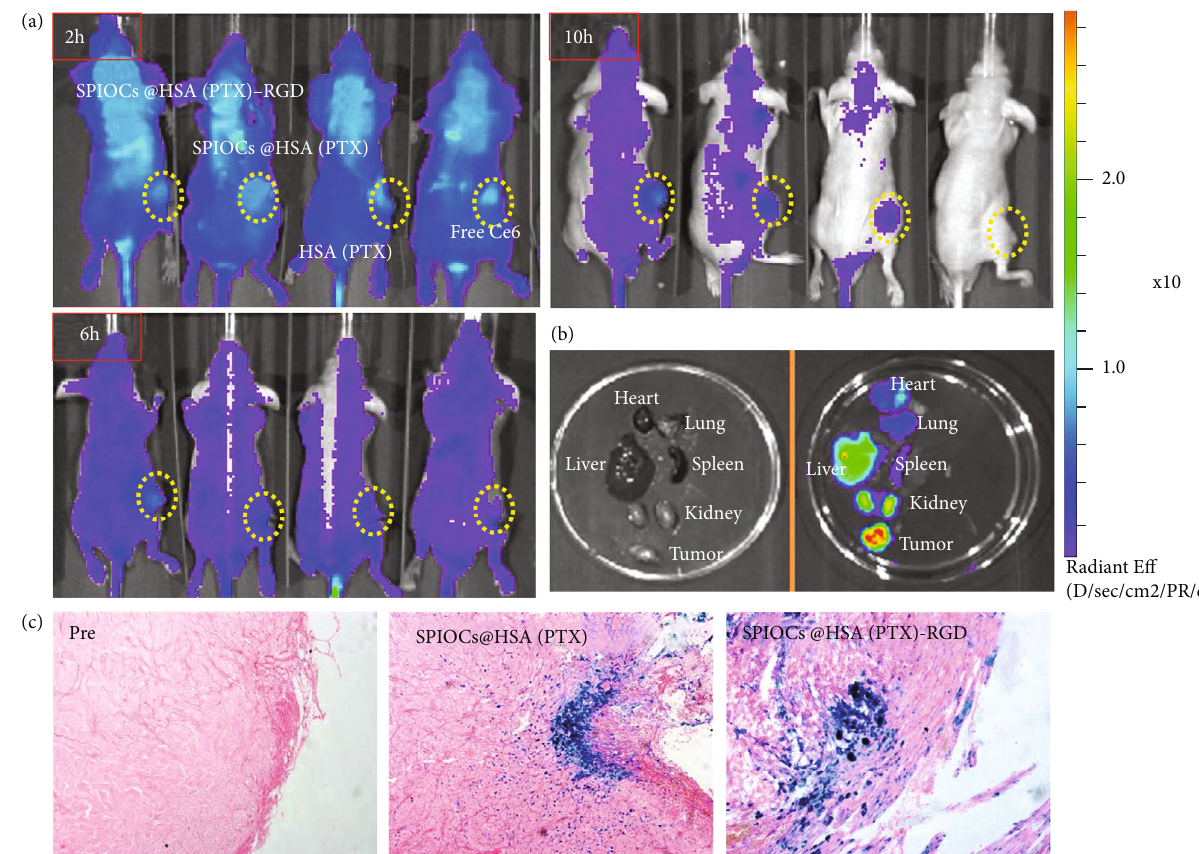
Figure 4: (a) Biodistribution of di ff erent nanoparticle groups recorded by IVIS fl uorescence images at 2-hour, 6-hour, and 10-hour postinjection. (b) Bioluminescence signals of ex vivo tumor and normal organs including the heart, lung, liver, spleen, and kidneys of SPIOCs@HSA(PTX)-RGD group. (c) Prussian blue-eosin double staining of tumor sections. Prussian blue-stained regions represented the iron nanoparticles deposited in tumor beds 10-hour